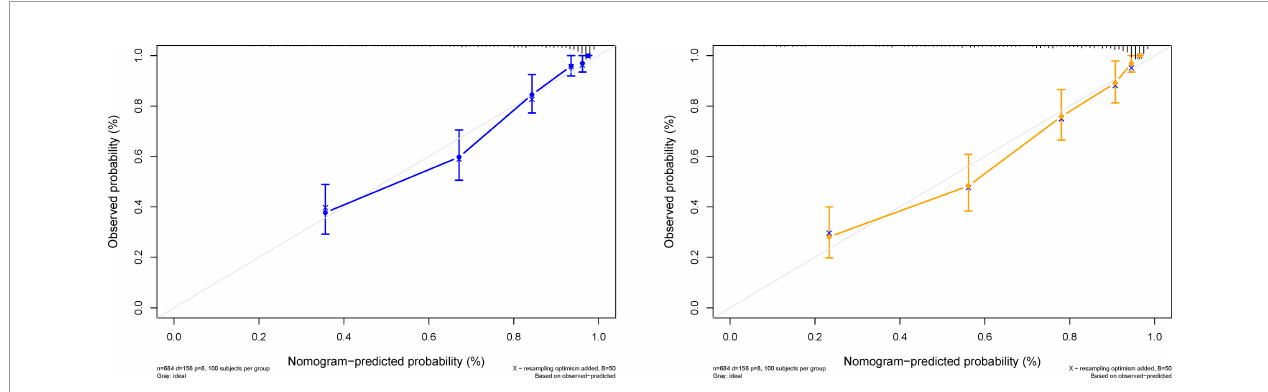
FIGURE 5 | Predicted probability of the 3- and 5-year survival time. The calibration curve of the DeepSurv nomogram. The diagonal gray line represents an ideal evaluation, and the solid blue and yellow lines represent the performance of the DeepSurv nomogram.